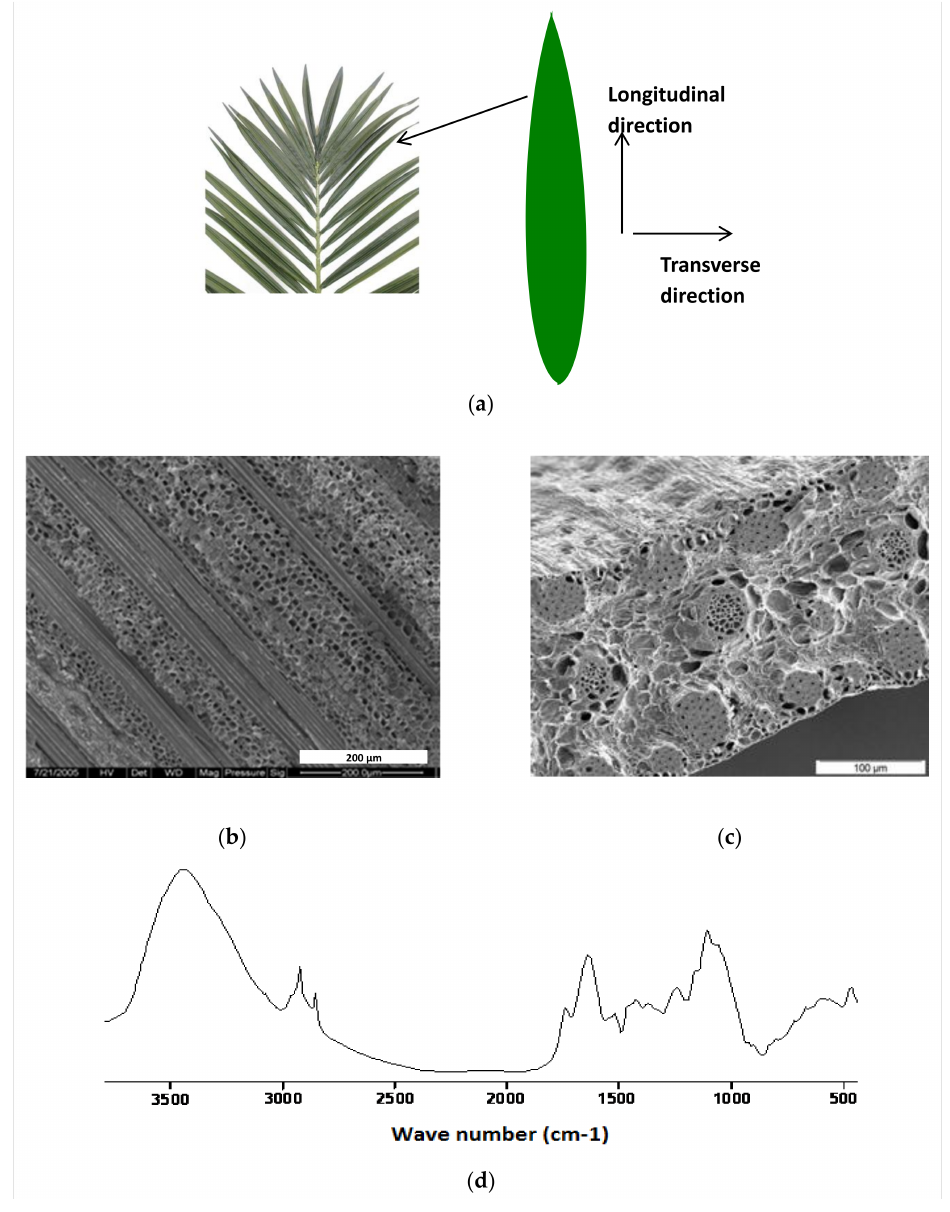
Figure 3. ( a ) Schematic presentation of the date palm tree fibers. ( b , c ) Longitudinal and transverse morphological structure of date palm fiber. ( d ) ATR-FTIR spectra of date palm